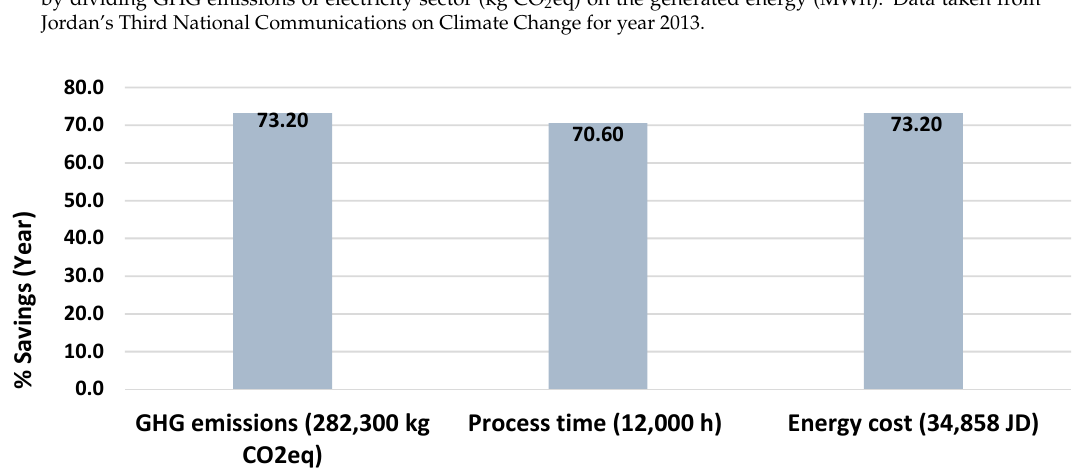
Figure 3. Percentual savings in process time, energy cost, and GHG emissions due to process improvement.